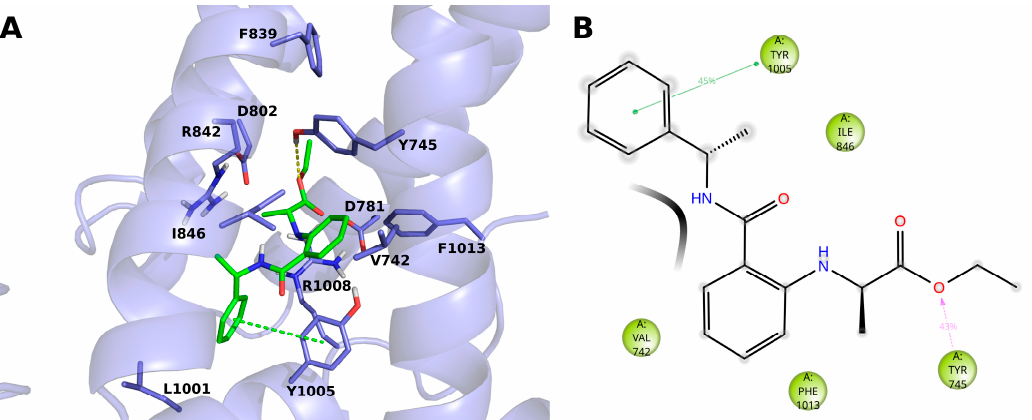
Figure 3. ( A ) Docking-predicted pose of 14 ( BB 0322703 ) into hTRPM8 723–1013 . hTRPM8 is represented in cartoons, and its residues interacting with the ligand are represented in sticks. 14 ( BB 0322703 ) in its hTRPM8-bound conformation is represented in solid green sticks. H-bonds are highlighted by yellow dashed lines, π – π interaction by green dashed lines. ( B ) Ligand interaction diagram of 14 (BB 0322703 ) in complex with hTRPM8. Only residues interacting with the ligand for at least 40 ns out 120 ns of MD simulation are shown. Hydrophobic residues are colored green. Grey halos highlight solvent exposure. H-bonds are represented by magenta arrows (dashed when side-chain atoms are involved); green solid lines represent π – π interactions.